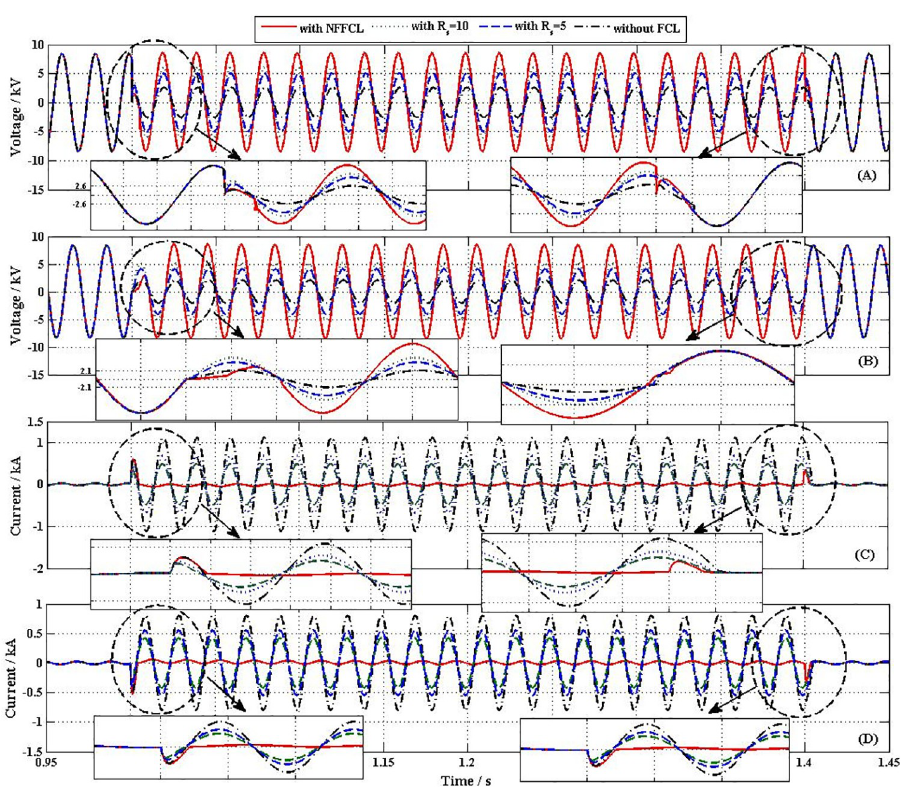
Fig 9. Transient performances curve of distribution network. (A) voltage of BUS1 (B) voltage of BUS3 (C) Output current of BUS1 (D) Output current of BUS3.